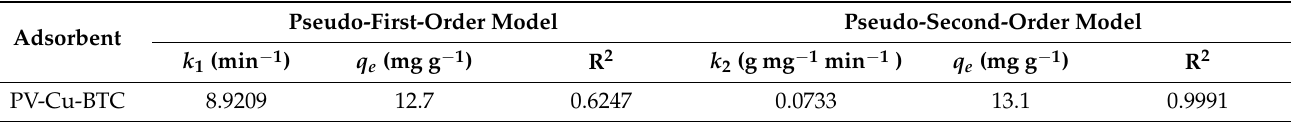
Table 3. Adsorption kinetic parameters for fitting results applying pseudo-first-order and pseudo- second-order